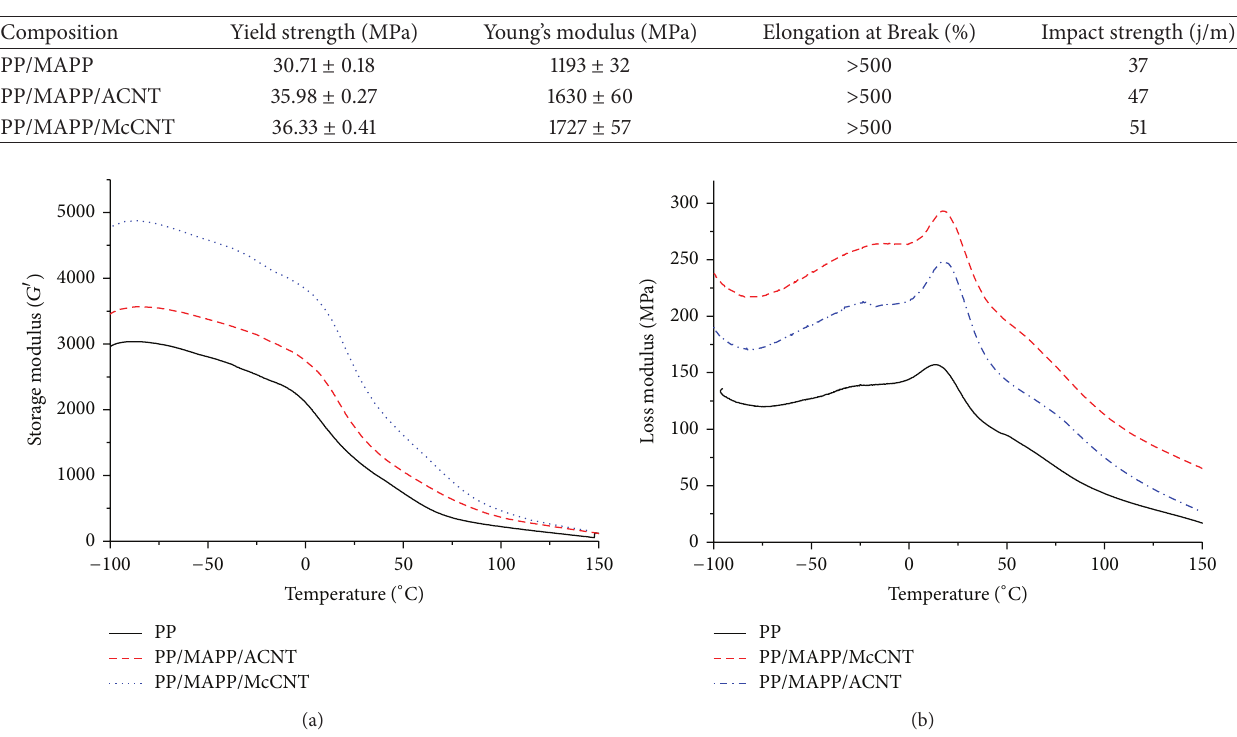
Table 1: Mechanical properties of PP and PP nanocomposites.